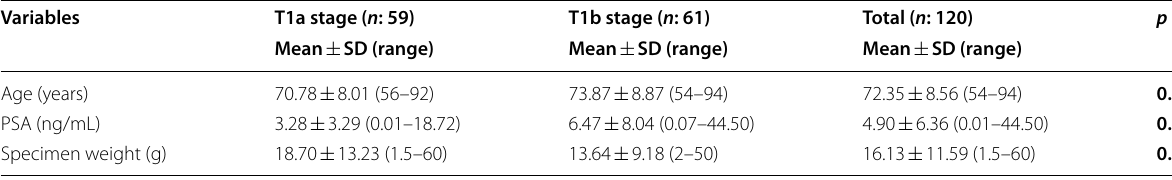
PSA prostate-specific antigen, SD standard deviation Bold values indicate statistical significance at the p < 0.05 level